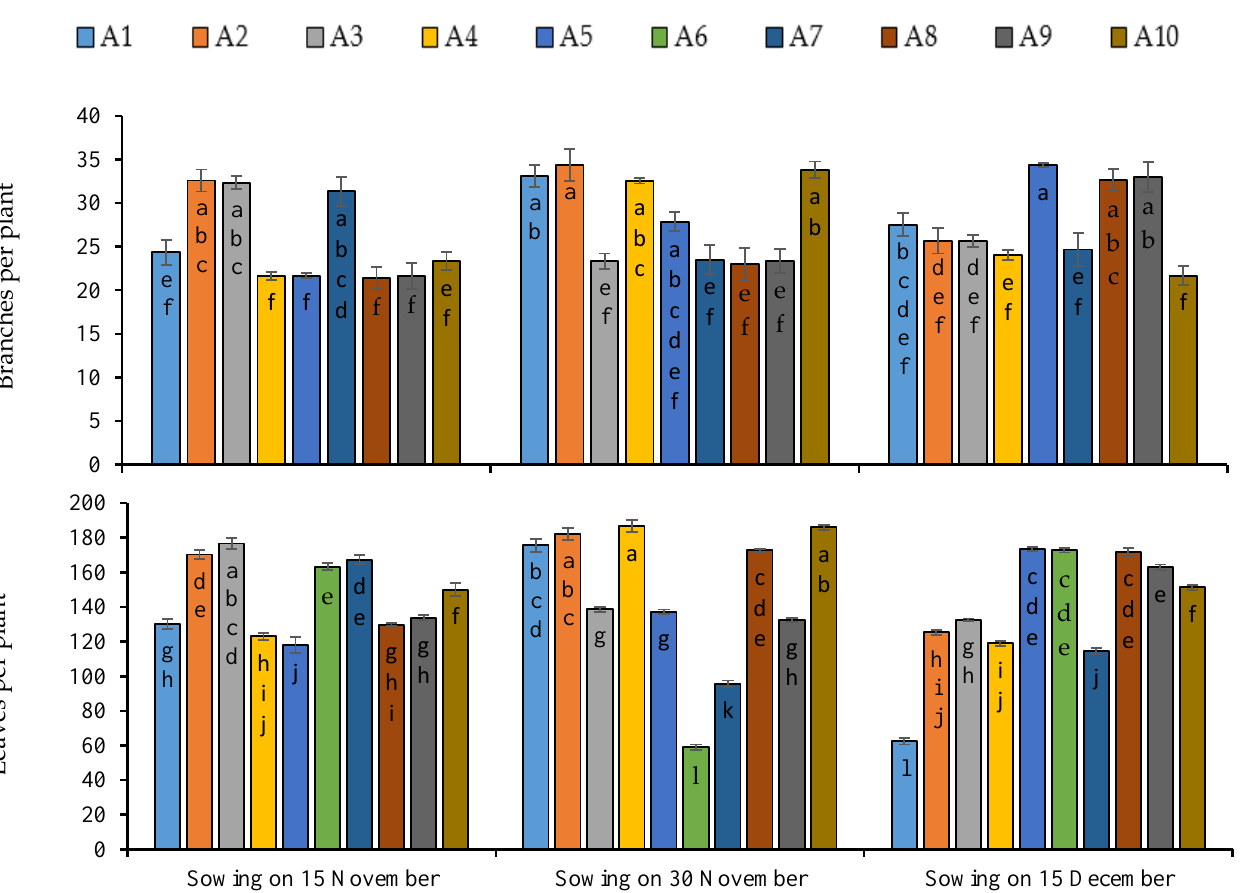
Figure 4. Number of branches and leaves per plant of quinoa lines grown under varying sowing dates. Bars sharing the same alphabet did not differ significantly at p < 0.05. Small alphabets (a, b, c. etc.) are used to express the statistically significant difference.